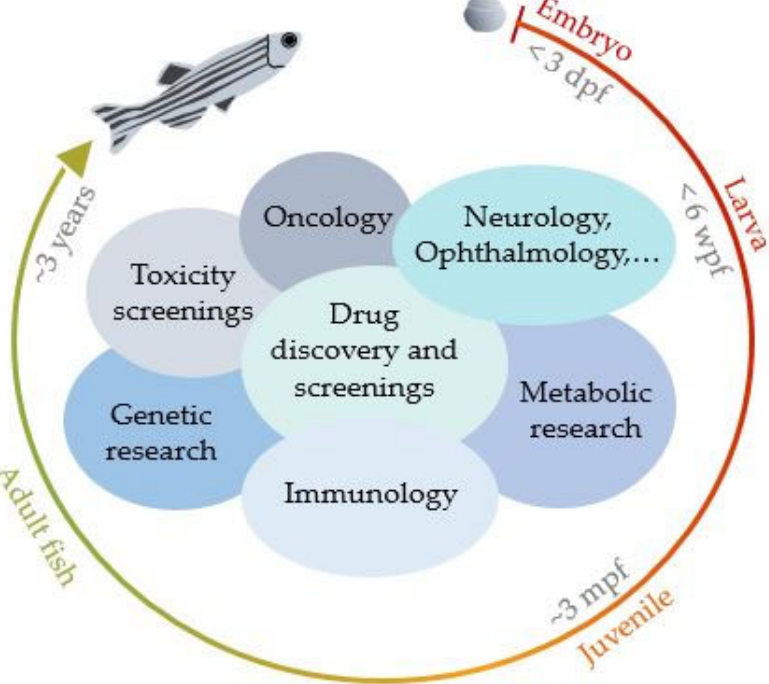
Figure 2. Biomedical applications/research areas in which zebrafish models have been utilized. (Days post ‐ fertilization—dpf, weeks ‐ post ‐ fertilization—wpf, months ‐ post ‐ fertilization—mpf). Zebrafish ‐ based research performed at early development stages by means of white light or fluorescence microscopic techniques takes advantage of the fast maturation time, small size of the animals and the semi ‐ transparency. These imaging techniques offer cel ‐ lular resolution and are compatible with markers to enable tissue specific contrast [13]. One important type of fluorescence imaging used in zebrafish investigations is light sheet